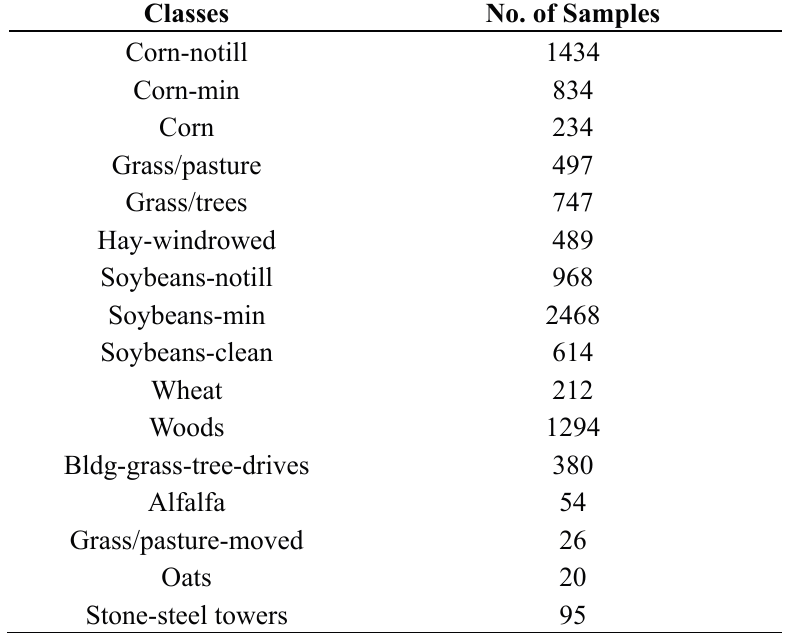
Table 10. The numbers of samples in the reference data for the AVIRIS Indian Pines